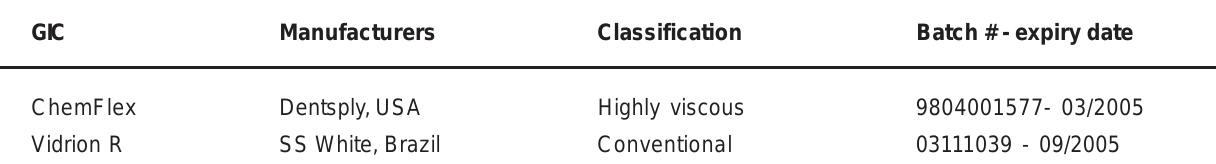
TABLE 1- Tested glass ionomer cements (GIC)